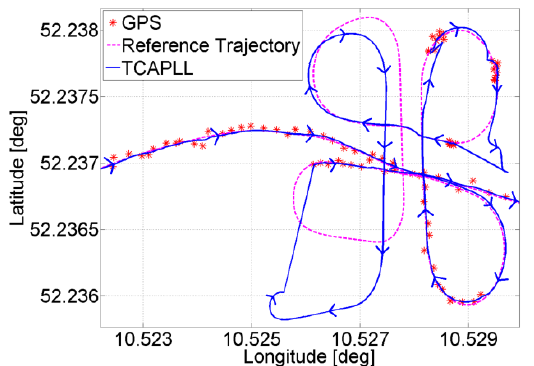
Figure 21. Position solution when GPS total outages